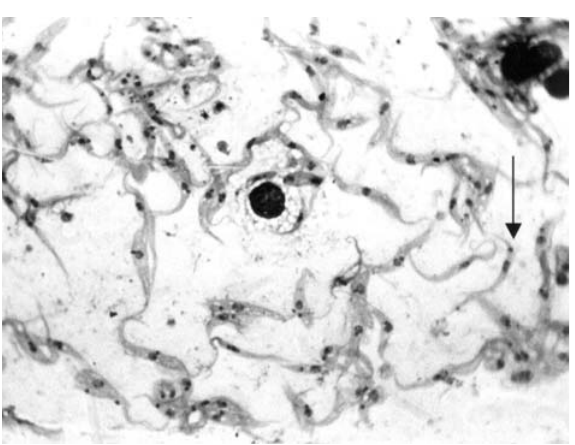
FIG. 6 Epimastigote (arrow), the most common form of T. thei- leri in the haemolymph